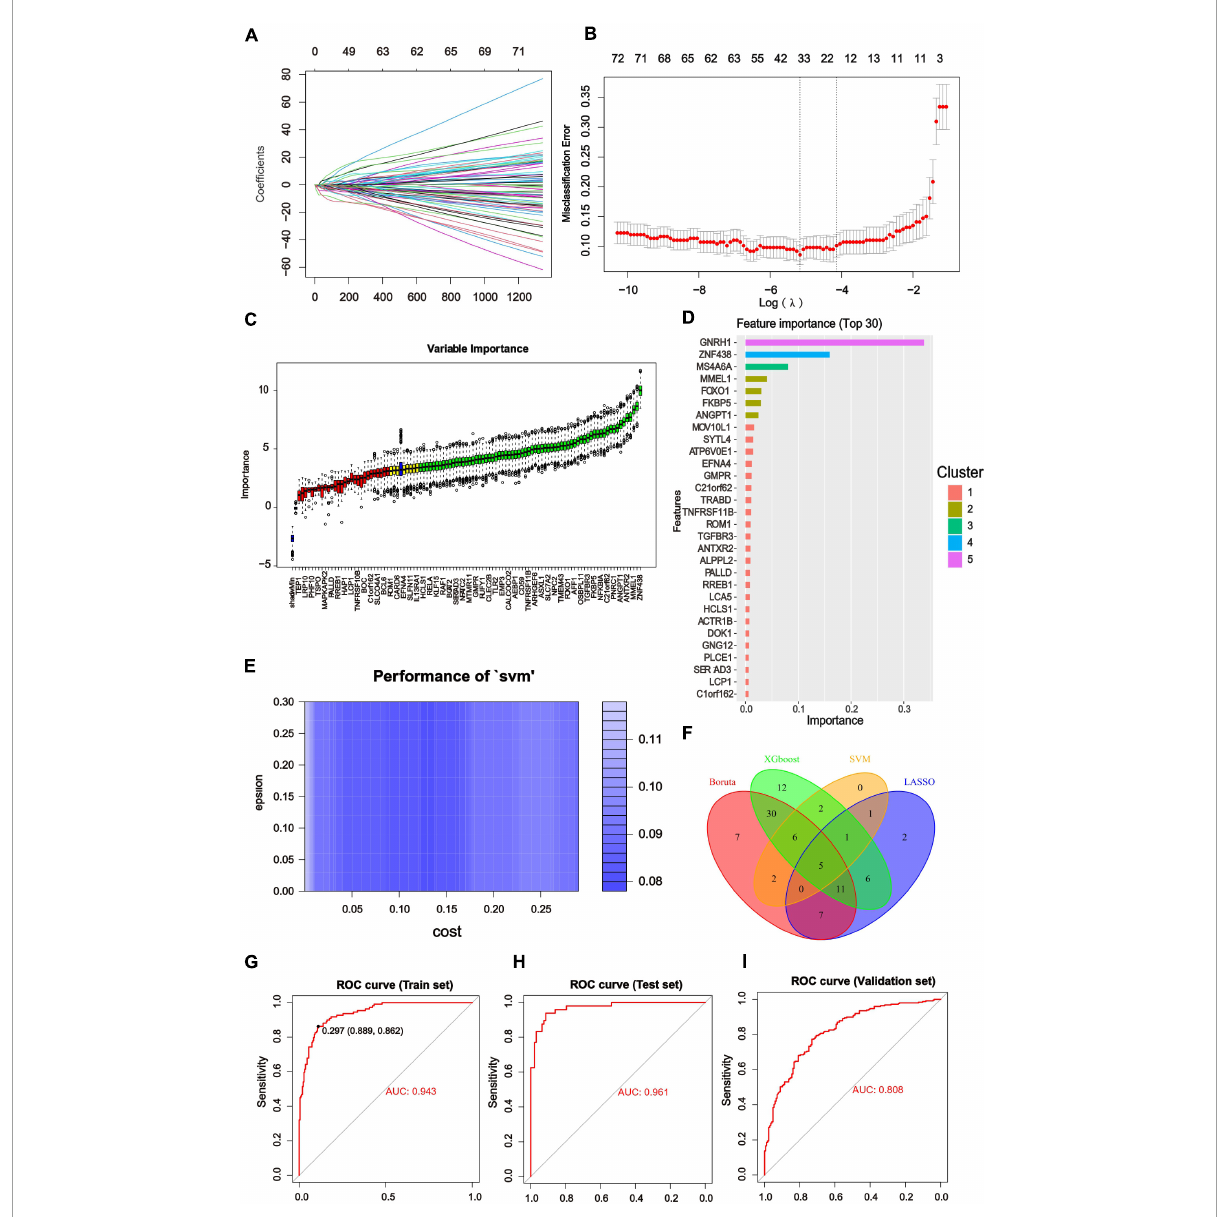
FIGURE5 Results of Machine Learning Algorithms and ROC curve. (A) LASSO coefficient profiles of the significant hub genes. (B) Cross validation for turning parameter (lambda) selection in the LASSO regression. The LASSO model selected the log( λ ) value for further analysis. (C) Screening conditions of Boruta algorithm. The green boxes confirmed the top 68 important features. The other two colors represented tentative and rejected attributes. (D) 125 hub genes identified by WGCNA were calculated by XGBoost and automatically ranked in order of importance. A list of the top 30 genes was predicted by XGboost classifier. (E) Using SVM modeling, 17 feature genes were extracted as gene biomarkers of AD from the aforementioned 125 hub genes. (F) Venn diagram to screen 5 overlapping genes presented in four Machine Learning Algorithms. (G–I) ROC curve was used to investigate the diagnostic model based on five diagnostic markers. The diagnostic model had the AUC value of 0.943 in the training set. The AUC of the test set was 0.961 and that of the validation set was 0.808. The X -axis represented the (1-specificity), and the Y -axis represented the sensitivity in the ROC